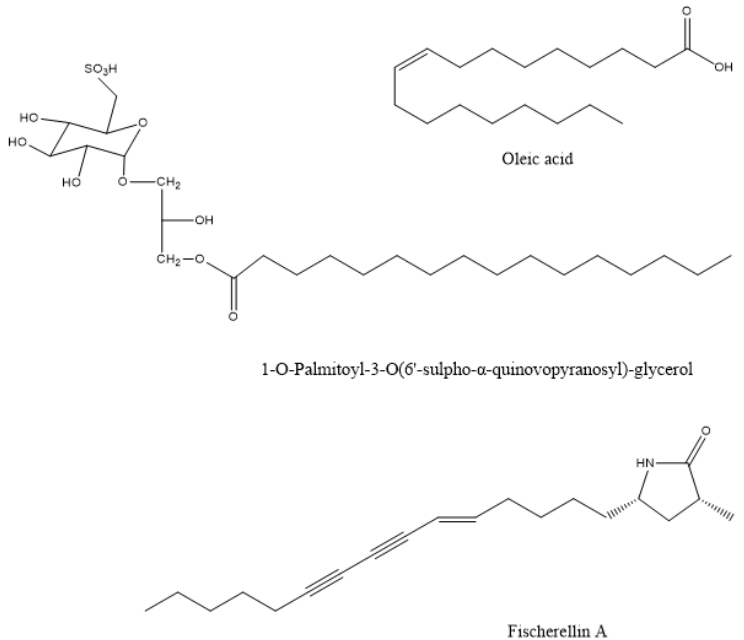
Figure 1. The chemical structure of active compounds that were isolated from Sargassum wightii , Padina gymnospora , and Fischerella muscicola.